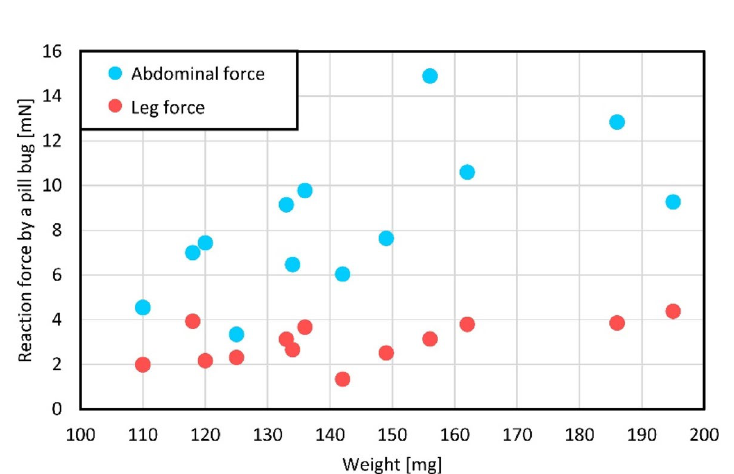
Figure 6. Leg forces and abdominal forces of pill bugs in relation to their weight. The weight distribution of the collected pill bugs was between 100 and 200 mg. The tendency of increasing the force in relation to the wight was